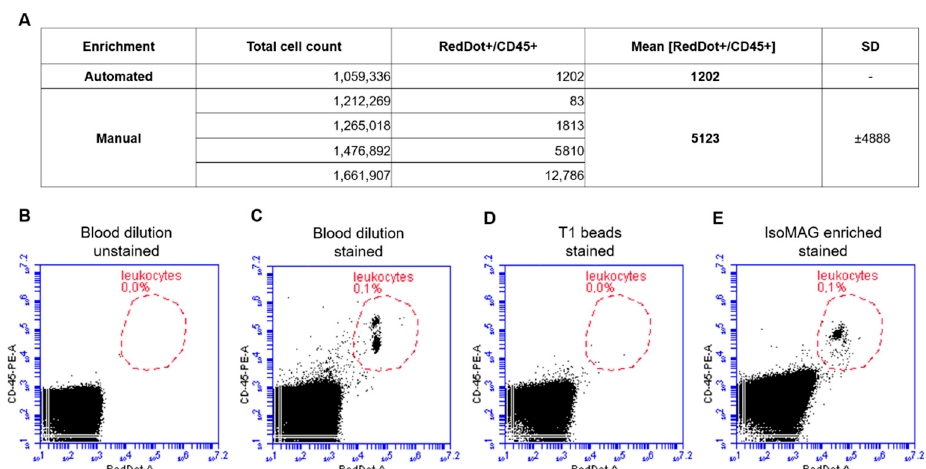
Figure 3. Automated immunomagnetic enrichment procedure exhibits a significantly lower amount of leukocyte contamination compared to manual cell isolation. ( A ) Summary of enrichment processes and quantification of leukocyte contamination. ( B – E ) After the automated enrichment process, cells were stained with CD45-PE antibody and nucleic staining reagent RedDot TM . Blood dilution (1:1000) shows a dual-positive cell population ( B , C ). After the enrichment process, this gating was used to quantify the leukocyte contamination ( E ) while showing no staining of the free beads themselves ( D ).